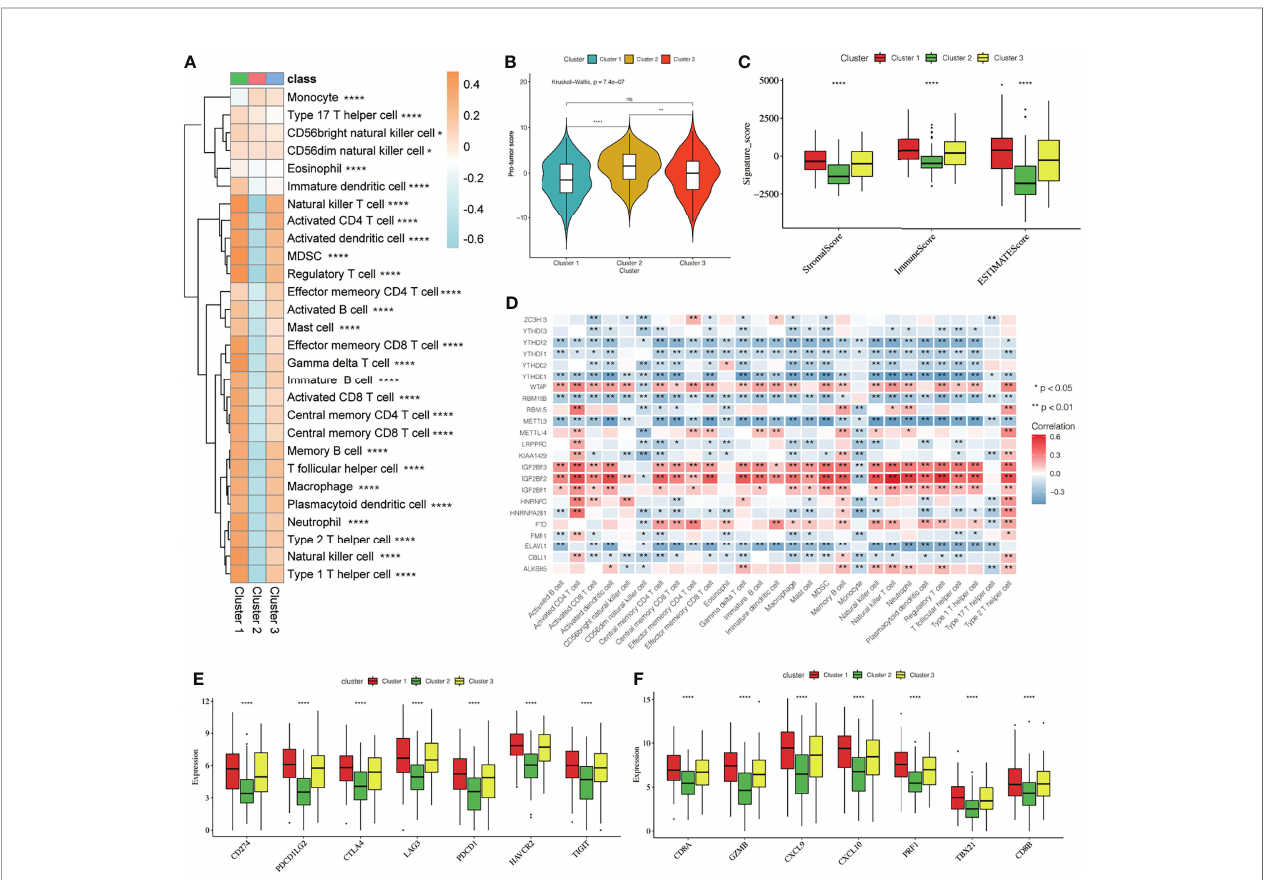
FIGURE 4 | Effect of m 6 A modi fi cation on immune cell in fi ltration and immune checkpoint expression in the tumor immune microenvironment. (A) The thermogram shows the difference in the average level of 28 kinds of immune cell in fi ltration among three different m 6 A modi fi cation patterns, the asterisk represents the statistical p-value (*P < 0.05; **P < 0.01; ****P < 0.0001). (B) The violin box chart shows the difference in Pro-tumor score, the asterisk represents the statistical p-value (*P < 0.05; **P < 0.01; ****P < 0.0001, ns P > 0.05). (C) The ESTIMATE algorithm estimates the ratio of immune and matrix components of each sample in TME. The histogram shows the difference in immune score, stromal score, and the ESTIMATE score among the three different m 6 A modi fi cation patterns. The asterisk represents the statistical p-value (*P < 0.05; **P < 0.01; ****P < 0.0001). (D) Thermogram showing the 23 m 6 A regulatory factors that were correlated with 28 kinds of immune cells. The darker color indicates a higher correlation. The asterisk represents the statistical p-value (*P < 0.05, **P < 0.01). (E, F) The Box plot shows the immune checkpoint-related gene (E) and the CD8 + T cell marker gene (F) among the three different m 6 A modi fi cation